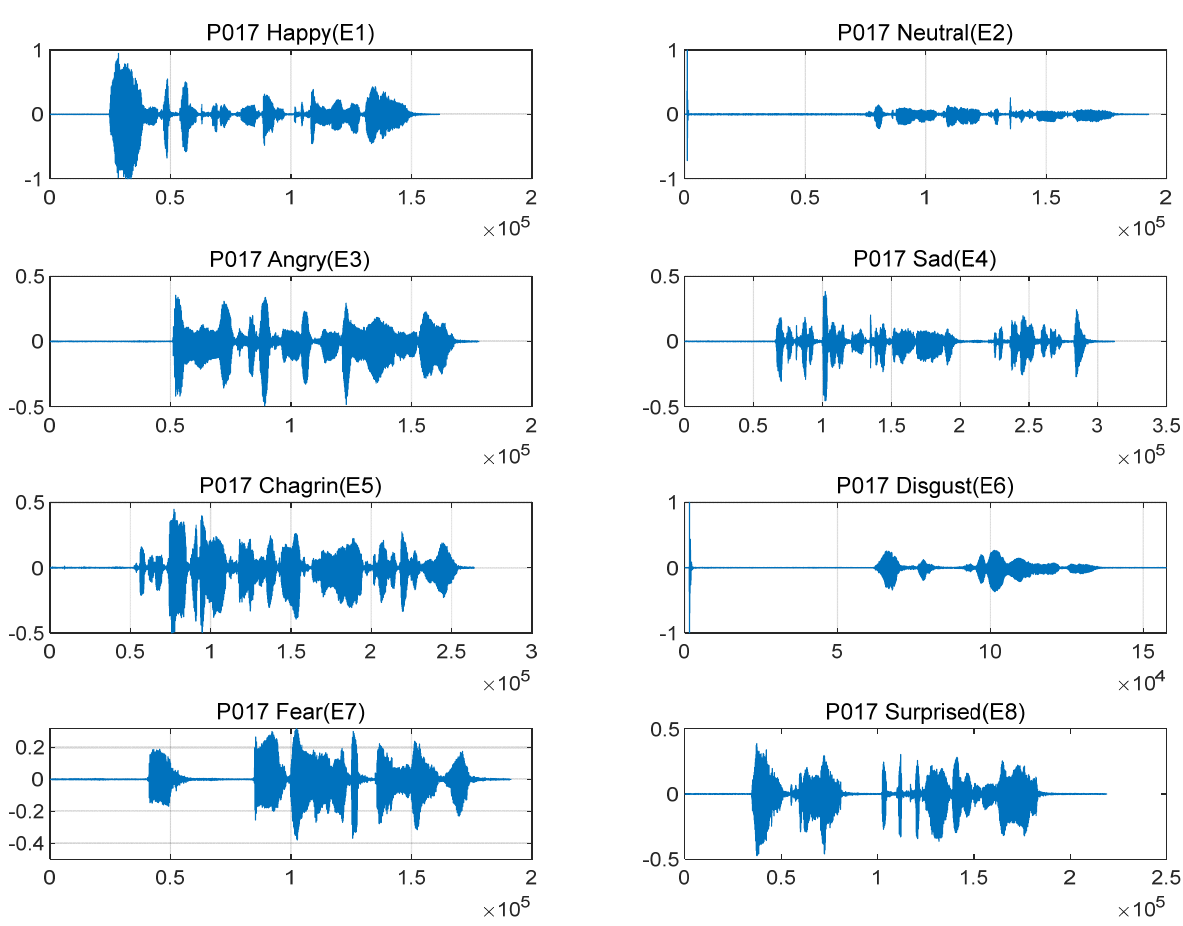
Figure 7. Visualization of speech data for eight emotions.